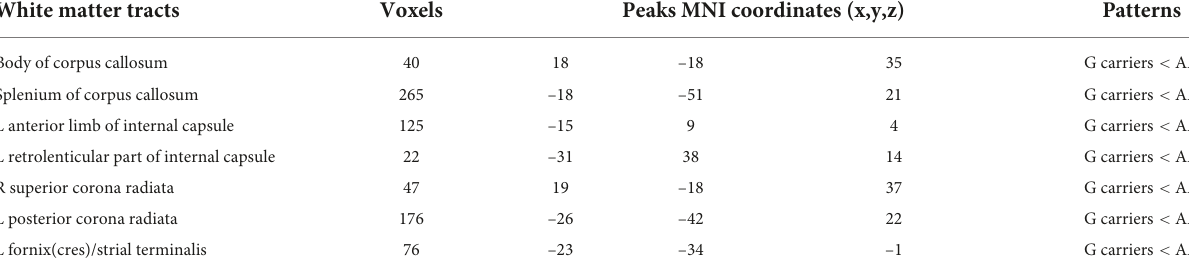
TABLE 2 White matter regions where Per1 Gene (rs7221412) variants between A/A and G carriers significantly differ in fractional anisotropy. White matter tracts Voxels Peaks MNI coordinates (x,y,z)